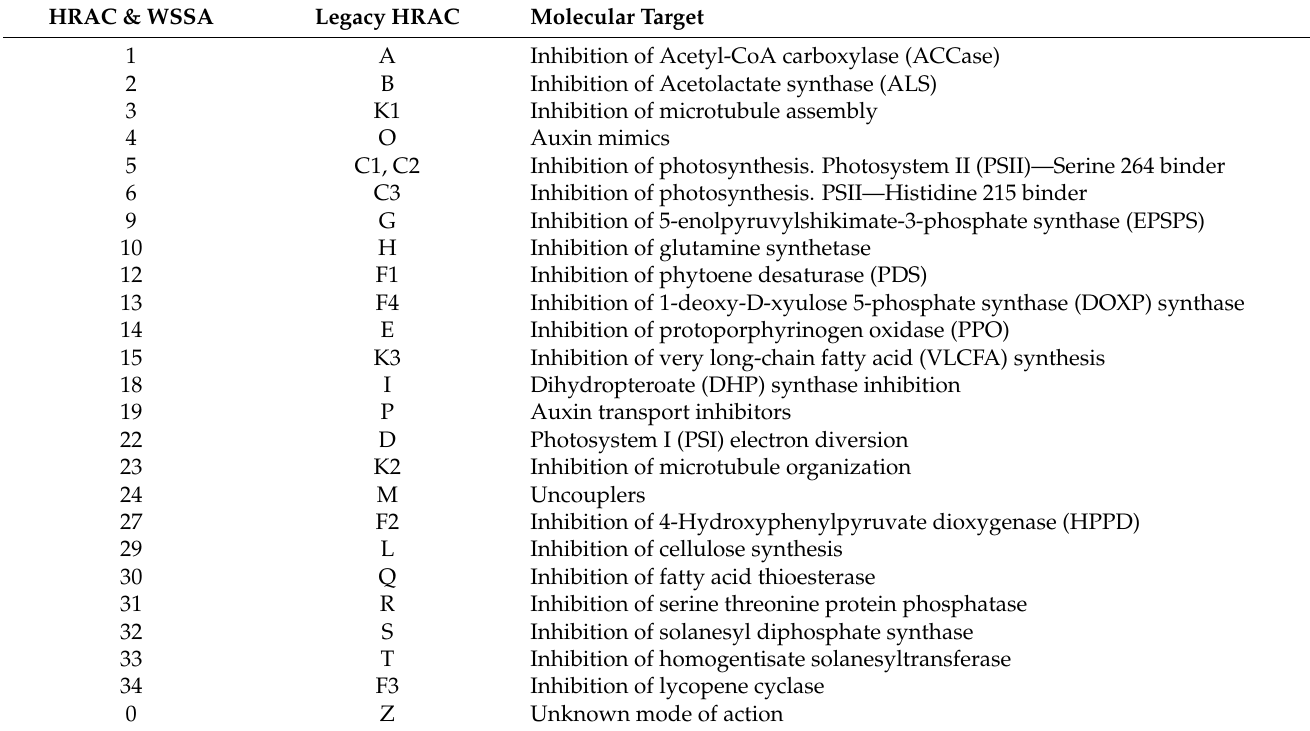
Table 3. Molecular targets of the 26 herbicide modes of action recognized by the HRAC and WSSA, together with the new classification system based on numbers (first column) and the former based on letters (second column). Adapted from the HRAC